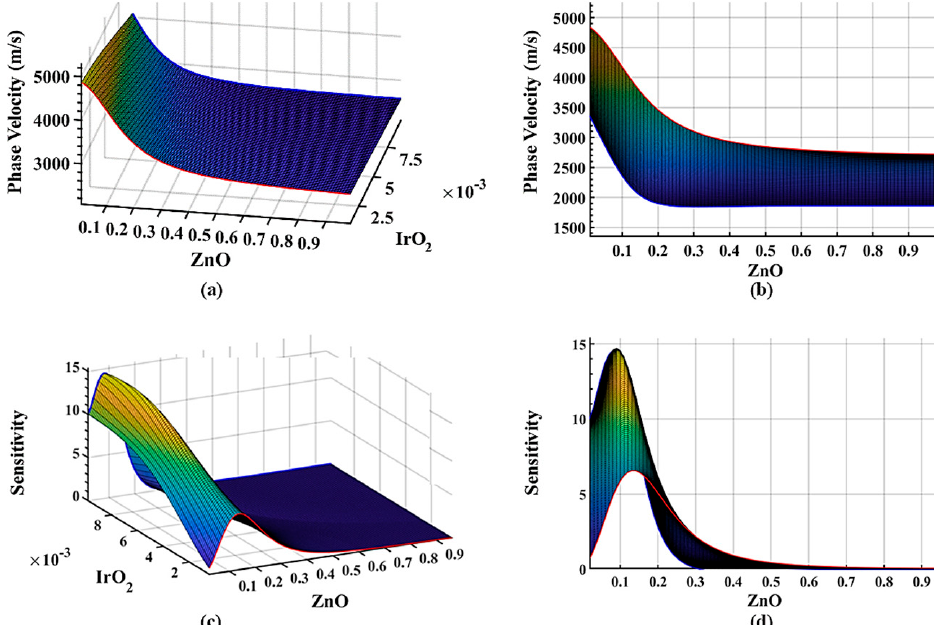
Figure 3. Dispersion surface plots of the four-layer system with a quartz substrate as the first layer, ZnO guided layer as a second layer, IrO 2 guided layer as the third layer, and a liquid layer normalized thickness of 0.025 at 100 MHz with relaxation time, ωτ = 10. The normalized thickness of the fluid layer is 0.025 with a constant viscosity of 20 cP. ( a ) Isometric view of the phase velocity dispersion with varying thicknesses of the first and second guided layers; ( b ) phase velocity vs. ZnO thickness variation; ( c ) isometric view of the mass sensitivity (unit: m 2 / kg) dispersion with varying thickness of the first and second guided layers; ( d ) sensitivity (unit: m 2 / kg) vs. the variation of the ZnO layer thickness.